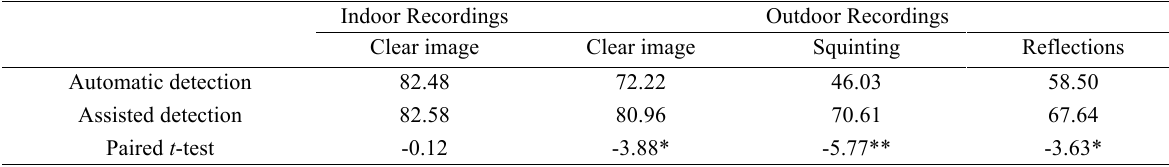
Proportion of recording time spent in (detected) fixations. Raw data and t-tests comparing fixation time with automatic versus assisted detection methods are shown below. Assisted detection does not influence the amount of time spent in fixations for indoor videos, but increases the proportion of fixation time for all outdoor videos, including those with a mostly clear eye image. Indoor